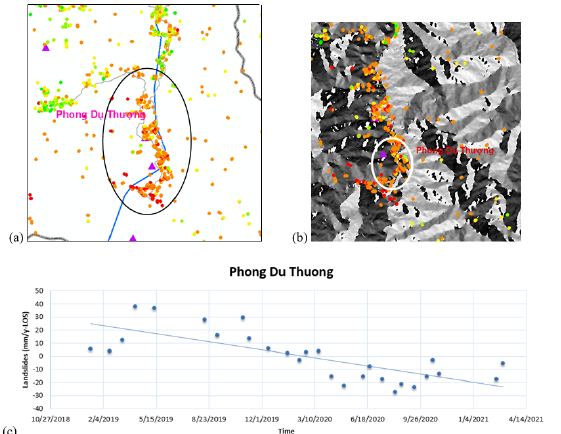
Figure 11. Distribution of permanent scatter points showing landslide rate, (b) the positions of PS points matched with survey point along the 151 road are superimposed on aspect map, (c) the chart of landslide point selected from